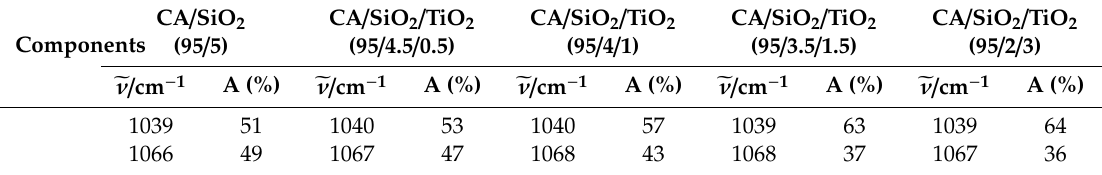
Table 5. Summary of the spectral deconvolution in the 1000–1110 cm − 1 region in series 1 (CA / SiO 2 / TiO 2 ).